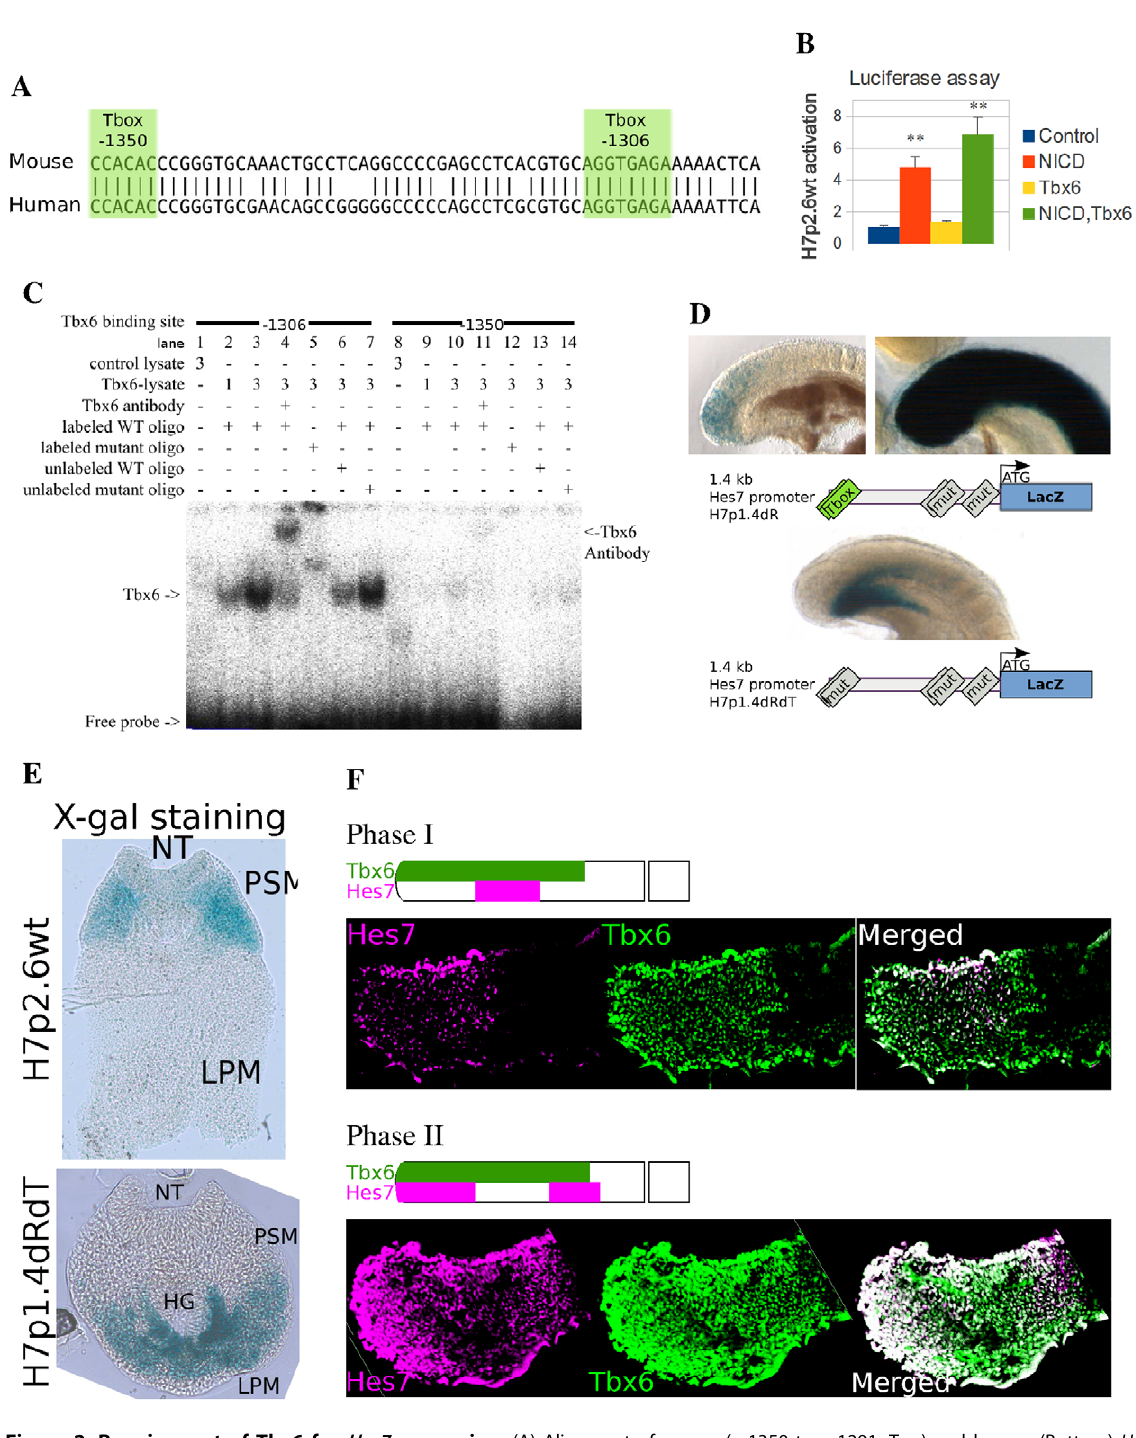
Figure 2. Requirement of Tbx6 for Hes7 expression. (A) Alignment of mouse ( 2 1350 to 2 1291, Top) and human (Bottom) Hes7 promoter sequences with two T-box binding sites (T-1306 and T-1350). (B) Luciferase assay of the H7p2.6wt promoter after transfection of NICD and Tbx6 expression plasmids. The Hes7 promoter is activated by NICD and further enhanced by Tbx6. (C) Electromobility gel shift assay (EMSA) of the T-box containing oligos and Tbx6. Tbx6 binds to T-box containing oligos. Conditions: control lysate (Lanes 1,8), low (Lanes 2,9) and high Tbx6 lysate concentration (Lanes 3–7,10–14), supershift for Tbx6 antibody (Lanes 4,11), wild-type (WT) (Lanes 2–4,6,7,9–11,13,14) and mutant labeled oligonucleotides (Lanes 5,12) and competition with unlabeled wild-type (Lanes 6,13) and mutant (Lanes 7,14) oligonucleotides. (D,E) X-gal staining of transgenic embryos with the H7p1.4dR (WT T-box sites; n=8) and H7p1.4dRdT (mutated T-box sites; n=2) reporter constructs and vibratome sections of control and H7p1.4dRdT reporters. Mutated T-box binding sites of the Hes7 promoter reporter prevent the WT X-gal staining (D). Vibratome sections of control reporter constructs with WT T-box binding sites show that all positive X-gal staining embryos also present staining in the paraxial mesoderm (E top, n=13). By contrast, reporter constructs with mutated T-box binding sites prevent paraxial mesoderm staining and induce lateral plate and ventral mesoderm staining (E bottom, n=2). NT, neural tube; PSM, presomitic mesoderm; HG, hindgut; LPM, lateral plate mesoderm. (F) Double immunofluorescence detection of Hes7 (magenta) and Tbx6 (green) (Phase I, n=3; Phase II, n=2). The anterior limit of Hes7 protein coincides or slightly exceeds the Tbx6 protein domain suggesting that the Hes7 mRNA domain is always included in the Tbx6 protein domain. doi:10.1371/journal.pone.0053323.g002 PLOS ONE |